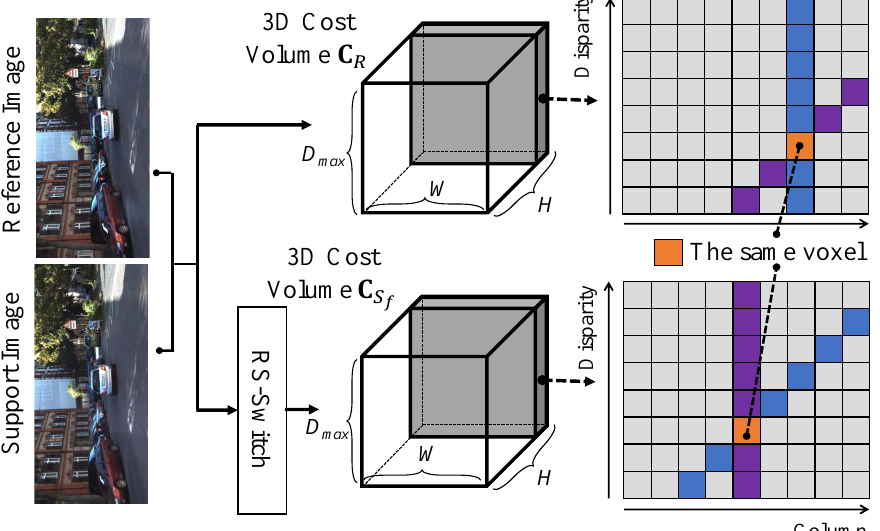
Figure 4. Illustration of cost volume inconsistency. A vertical cost pillar in C R is linked to a tilted cost pillar in C S . The orange pixels in C R and C S f